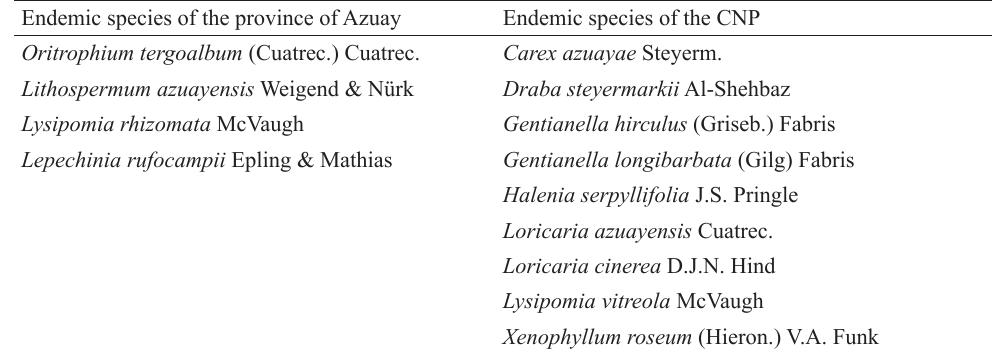
Table 1. Endemic species to Azuay and to the CNP in the catalogue (Appendix 1). Endemic species of the province of Azuay Endemic species of the CNP Oritrophium tergoalbum (Cuatrec.) Cuatrec. Carex azuayae